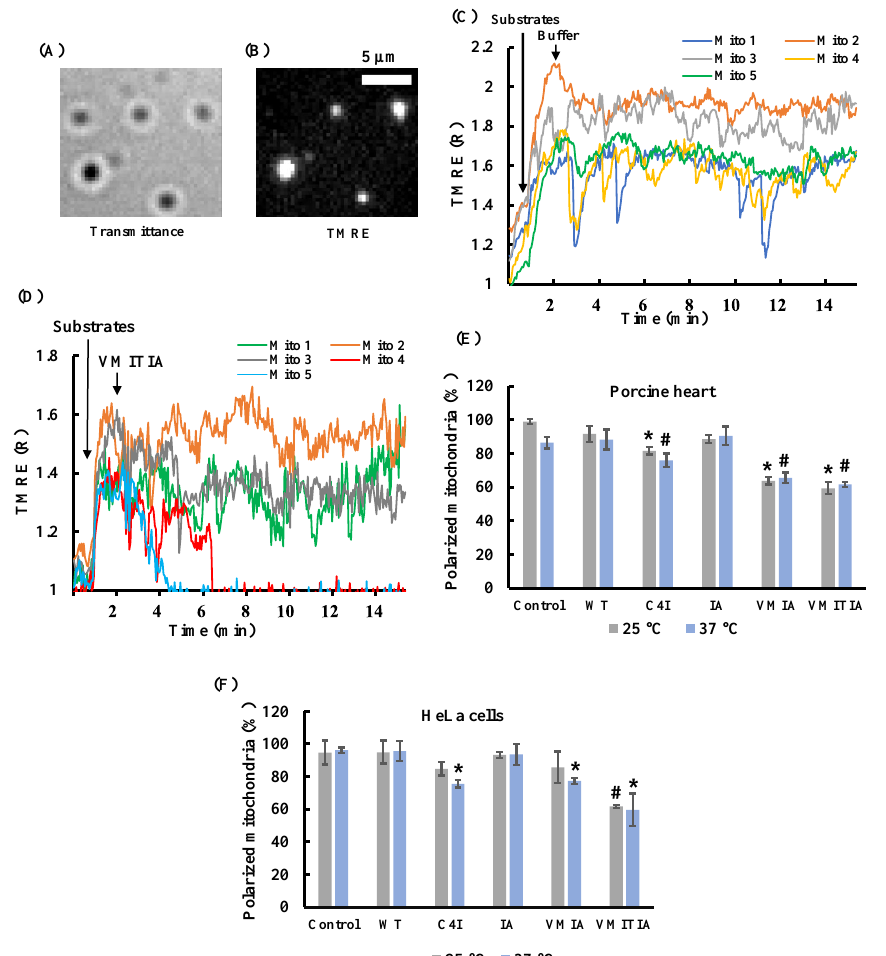
Figure 1. Effects of DENV3-ED3 variants on mitochondrial membrane potential. ( A , B ) Optical images of mitochondria isolated from porcine hearts. ( A ) Brightfield and ( B ) TMRE fluorescence images of the same microscopic field. Bar, 5 µ m; ( C , D ) time course of the normalized TMRE fluorescence (TMRE(R)) in five isolated mitochondria. At t = 0.5 min, 5 mM malate and 5 mM glutamate were added. At t = 2 min, ( C ) Tris-sucrose buffer or ( D ) 50 µ M VMITIA were added; ( E , F ) percentage of polarized mitochondria isolated from ( E ) porcine hearts and ( F ) HeLa cells respectively, after 10 min exposure to the indicated DENV3-ED3 variant (50 µ M) at 25 or 37 ◦ C. Polarized mitochondria were defined as mitochondria with TMRE (R) > 1.30 after malate and glutamate addition. Data represent the mean ± SEM of three independent experiments. Over 50 mitochondria were analyzed per experiment. * p < 0.05 vs. WT at 25 ◦ C; # p < 0.05 vs. WT at 37 ◦ C for ( E ). * p < 0.05 vs. WT at 37 ◦ C; # p < 0.05 vs. WT at 25 ◦ C for ( F